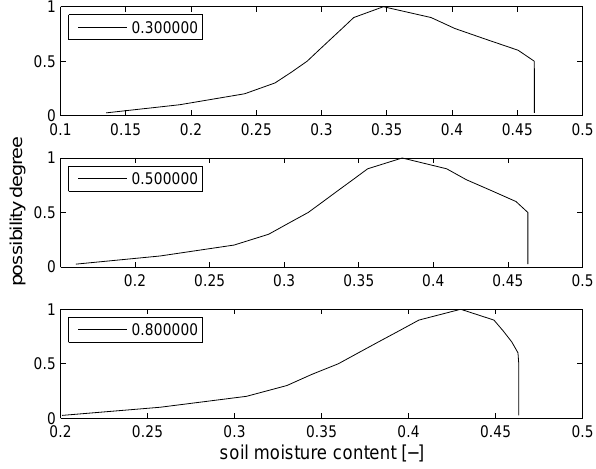
Fig. 7. Cross sections of the bundle of cumulative normal distributions at probability degrees 0.3, 0.5 and 0.8.